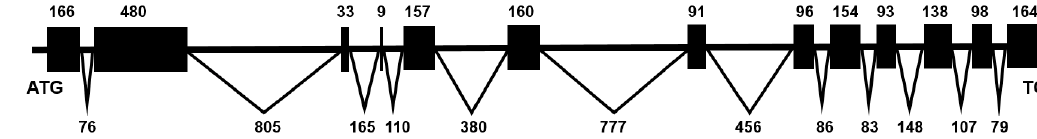
Figure 2. PsLyk9 gene structure. The exon (boxes) and intron (line) size in nucleotides are presented in cv. Finale background.